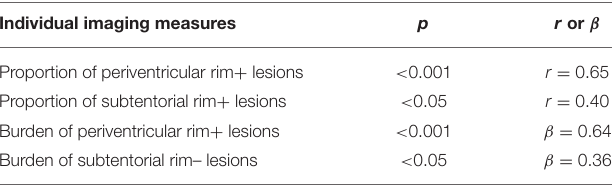
TABLE 2 | Significant associations between imaging findings and annual relapse rate. Individual imaging measures p r or β Proportion of periventricular rim + lesions < 0.001 r = 0.65 Proportion of subtentorial rim + lesions < 0.05 r = 0.40 Burden of periventricular rim + lesions < 0.001 β = 0.64 Burden of subtentorial rim– lesions < 0.05 β =